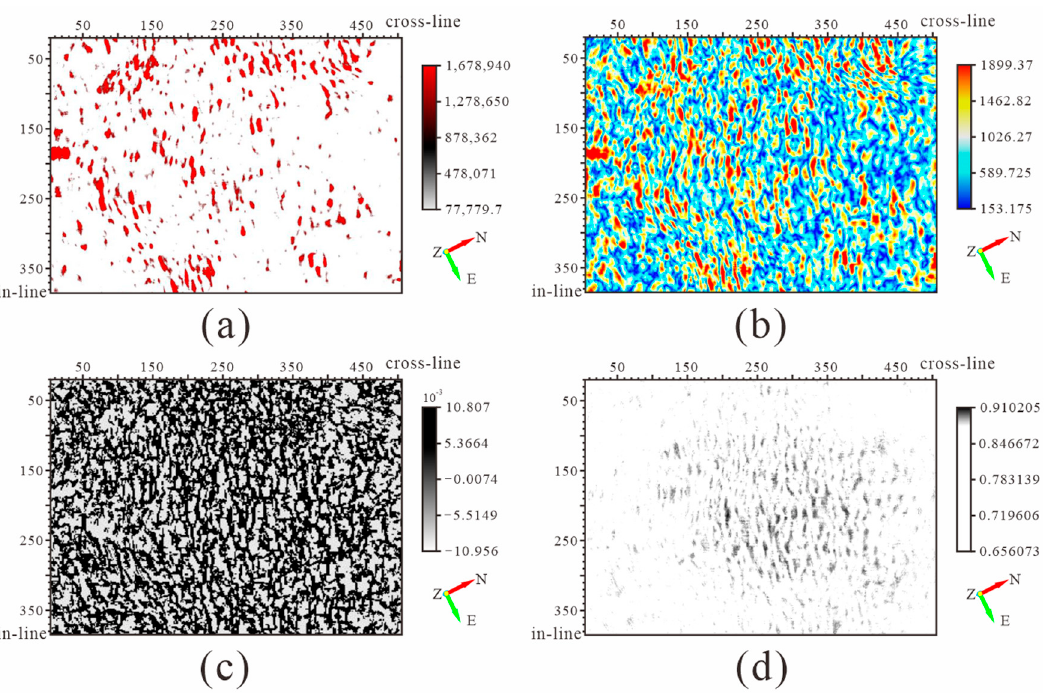
Figure 11. Diffraction attributes diagram of test slice. ( a ) The average energy attribute; ( b ) the instantaneous amplitude attribute; ( c ) the maximum positive curvature attribute; ( d ) the coherence attribute. Both ( a , b ) have better fracture performance in the northeastern region of the whole working area, while ( c ) describes the cracks in the working area as being mainly distributed in the northern section of the working area and ( d ) shows that the fractures are mainly distributed in the middle of the public area. The result of diffraction attribute fusion synthesizes their advantages and reflects the cracks in the working area.